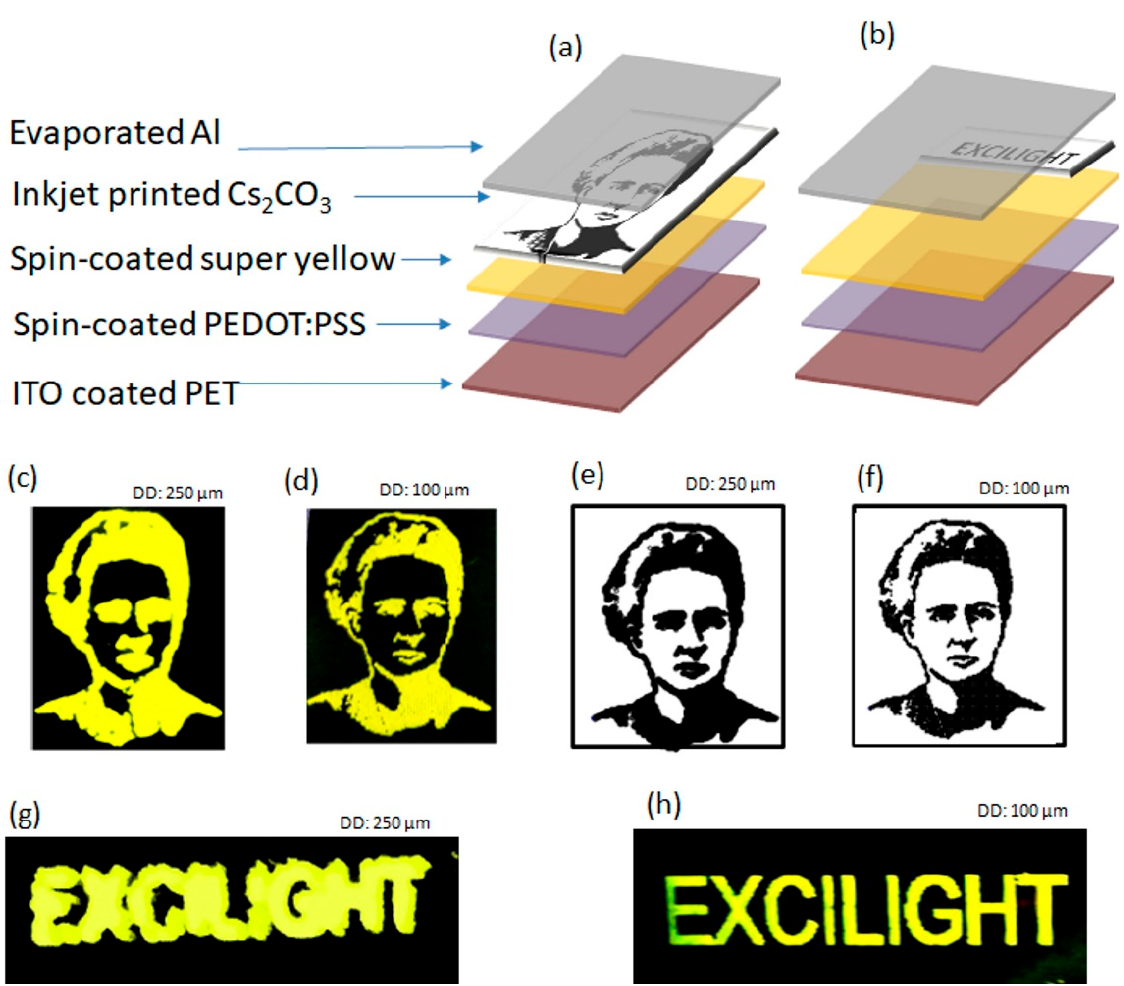
Figure 10. Schematic structure of PLEDs where an emission area is defined by printed Cs 2 CO 3 pattern: ( a ) Marie Skłodowska Curie portrait and ( b ) text “EXCILIGHT”. Pictures of PLEDs emitting light under applied voltage of 6V printed with ( c ) 250 µ m drop diameter and ( d ) 100 µ m drop diameter. Simulated image ( e ) 250 µ m drop diameter and ( f ) 100 µ m drop diameter. The text “EXCILIGHT” printed with ( g ) 250 µ m drop diameter and ( h ) 100 µ m drop diameter. The emission area of OLEDs of Marie Skłodowska Curie portrait was 15 mm × 10 mm and of the “EXCILIGHT” word is 15 mm × 3 mm.